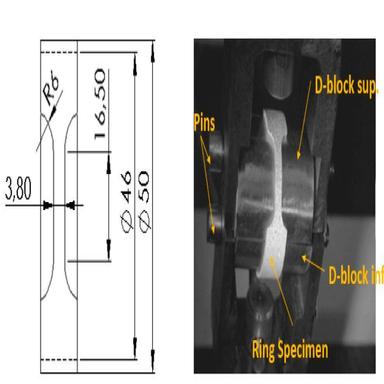
(a) Engineering drawing of the RHTT specimen; (b) tensile loading fixture tool used for the RHTT (speckle pattern on the specimen for DIC acquisition).